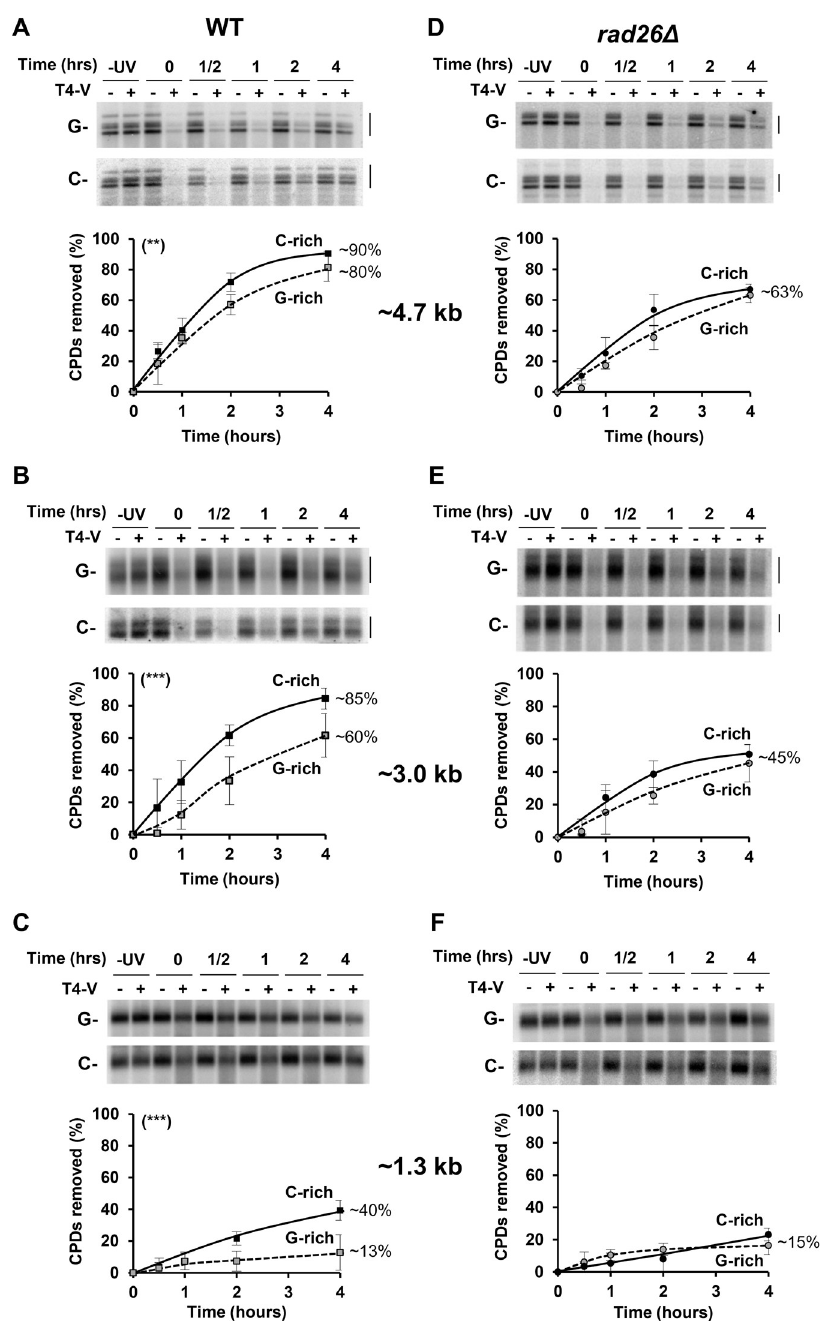
Fig 2. NER in the Y’-element telomeres. WT and rad26 Δ yeast were irradiated at 180 J/m 2 and harvested at the indicated times in hours (hrs). Isolated DNA from non-irradiated ( − UV) and irradiated cells (0 to 4 hrs) were digested with HindIII , EcoRI and XhoI ( Fig 1A ), and mock treated or treated with T4 endo-V (T4-V), denoted by − and +, respectively. After separation of the DNA fragments in 1% alkaline agarose-gels and blotting, the filter membranes were hybridized with single-stranded, strand-specific oligonucleotides ( Fig 1A and S2 Table : Y’F and Y’R). The band signals correspond to the average of all Y’-elements in the cell. (A and D) Quantification of CPDs in the ~4.7 kb HindIII / EcoRI group of bands formed by the 4.4, 4.7 and 5.0 kb fragments (brackets). At 0 hour repair, on average for the C-rich strand 0.67 ± 0.07 CPD/kb, and for the G-rich strand 0.56 ± 0.09 CPD/kb. (B and E) Quantification of CPDs in the ~3.0 kb HindIII fragment, made of ~2.7 kb of Y’-element sequences and variable lengths (average 0.3 kb) of telomere repeats. At 0 hour repair, on average for the C-rich strand 0.69 ± 0.38 CPD/kb, and for the G-rich strand 0.43 ± 0.01 CPD/kb. Measurements were taken of the broad bands (brackets). (C and F) Quantification of CPDs in